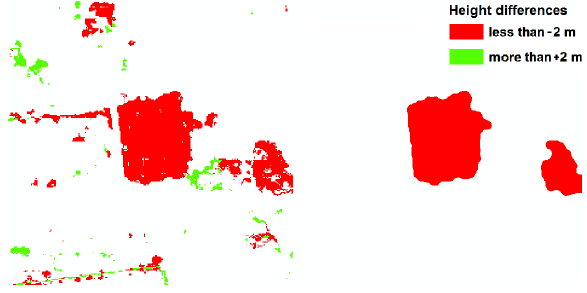
Figure 8. Left: classified DDSM Right: classified DDSM after filtering and smoothing